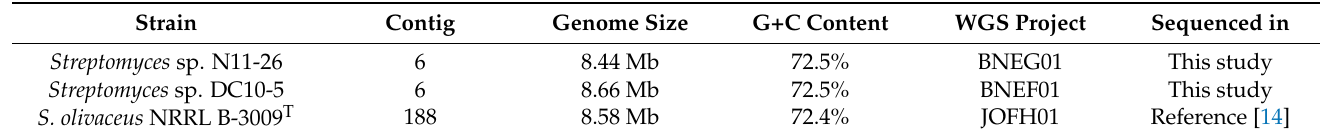
Table 1. Whole-genome sequences of Streptomyces sp. N11-26, Streptomyces sp. DC10-5 and a type strain of their closest species.